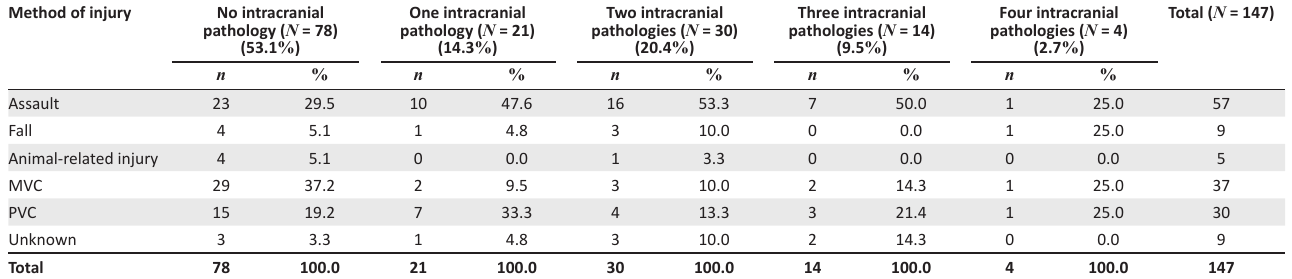
TABLE 3: Mechanisms of injury according to the number of intracranial pathologies sustained. Method of